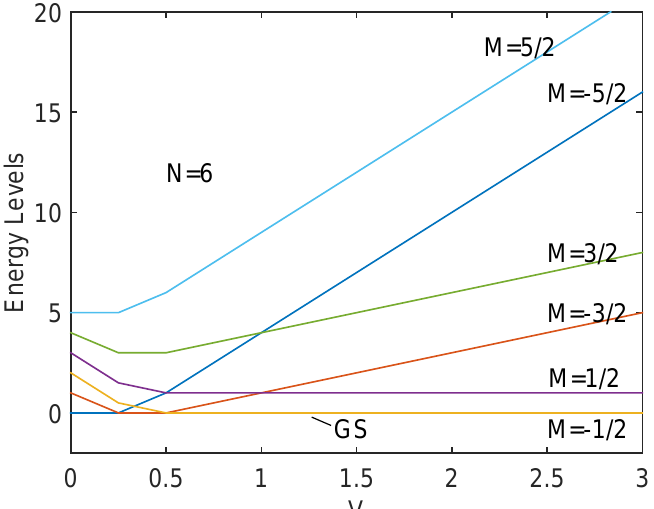
Figure 2. Level energies for the ground state (GS) and the first five excited states versus the coupling constant V of our fermion model. The number of fermions is N = 6. Energies are re-normalized so that the one for the ground state always equals zero. We note that the energy of the first excited (1ex) state (red line) is, for almost every V − value, very close to that of the GS. This fact results in two Boltzmann exponential factors of quite similar nature, i.e., similar probabilities. The remaining four excites states’ energies (second to fifth) grow very rapidly with V and this distances them more and more from the almost constant energy pair [GS, 1ex]. This makes the respective probabilities of these four excited states grow progressively smaller. Probabilistically then, our scenario is dominated by the pair [GS, 1ex].